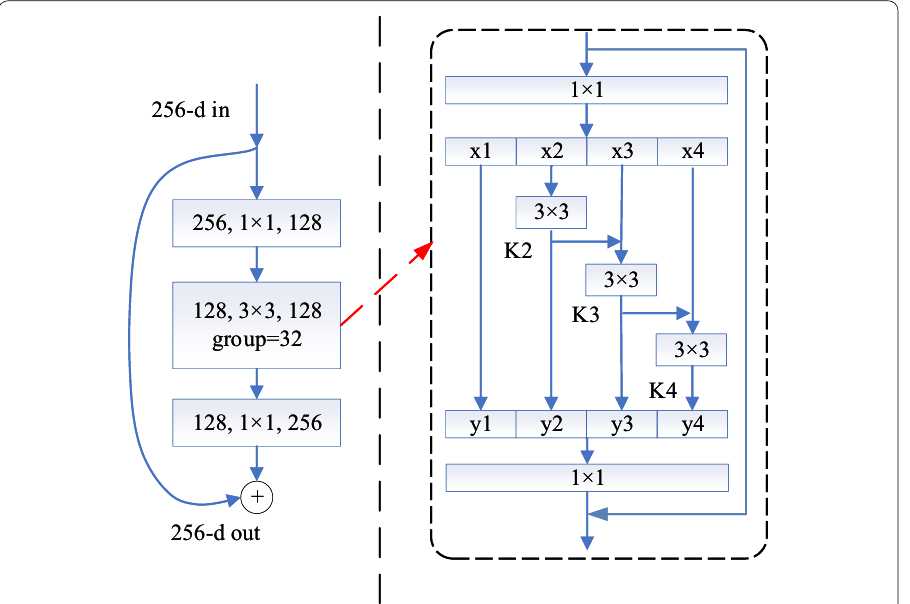
Fig. 4 The ResNet is optimized by combined ResNeXt and Res2Net (Variable cardinality C dimension s =